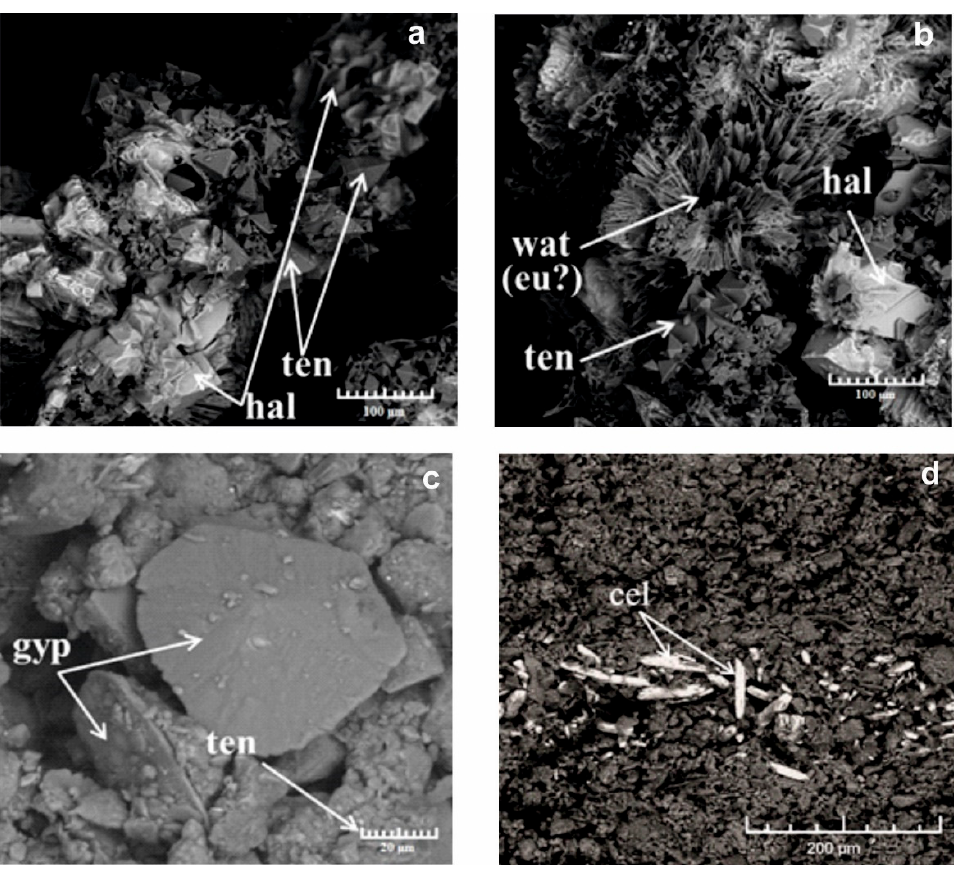
Figure 4. Images of the salt crust of lake sediments. ( a – d ): hal—halite, ten—thénardite, wat—wattevillite, eu—eugsterite, gyp—gypsum, cel—celestine.